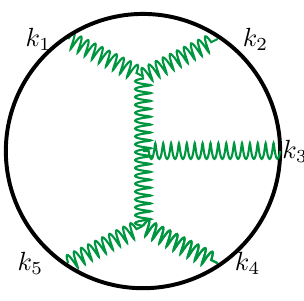
Figure 4 . Five point type-a vector